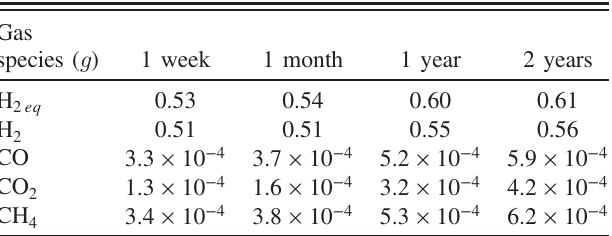
TABLE III. η 0 over time, in molecules/photon, as interpolated ph from the experimental data published in [41] and calculated for the coverage values shown in Fig.